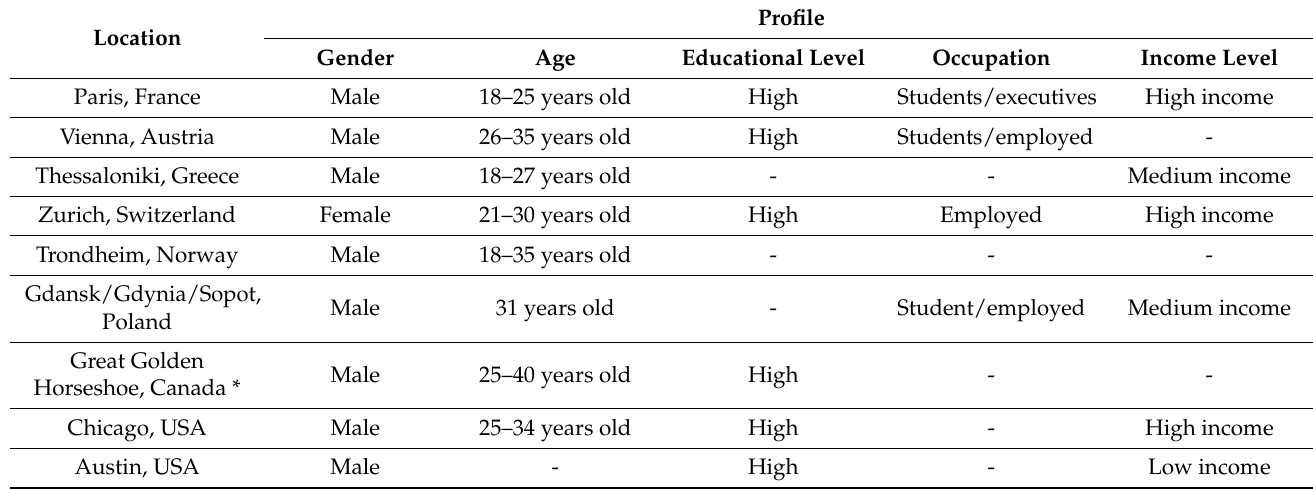
Table 1. Socioeconomic profile of shared e-scooter